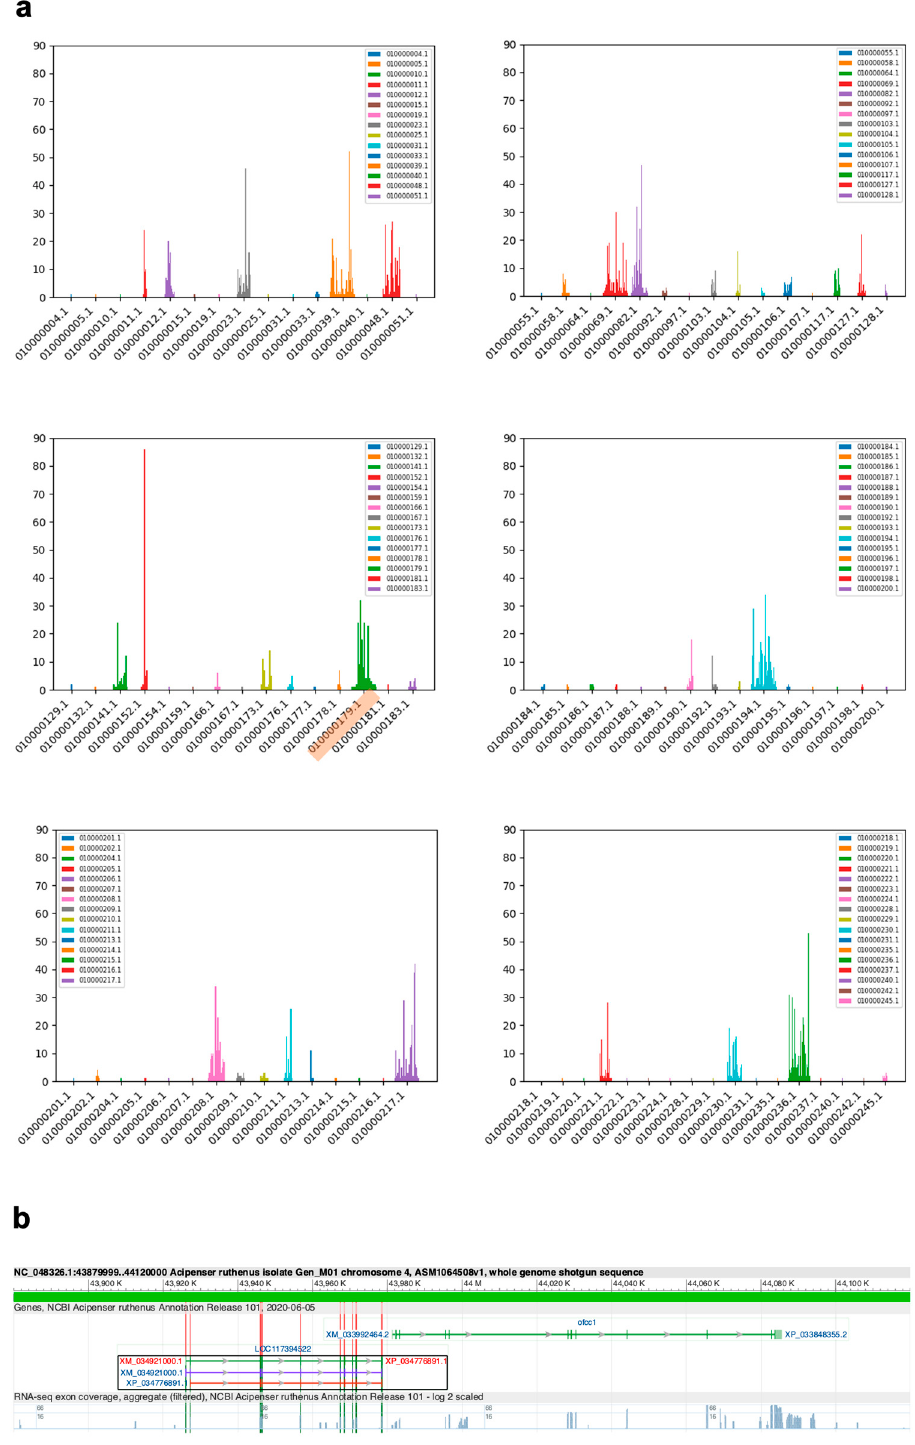
Figure 5. ( a ) Counts of inter-sex variation in AG in each 10 kb fragment, mapped to contigs in the AR female reference genome. Only segments with at least one variation, across 92 out of 245 contigs, are shown. The previously described sex-variable region maps to contig CACTIG010000179.1 (highlighted) and is associated with a cluster of 32 inter-sex variants. The first five panels show 15 contigs, and the last one shows 17 contigs. ( b ) Genome browser view of ofcc1 and the homologous LOC117394522, the genes nearest to the previously described sex-variable region, mapped to the AR male reference genome.